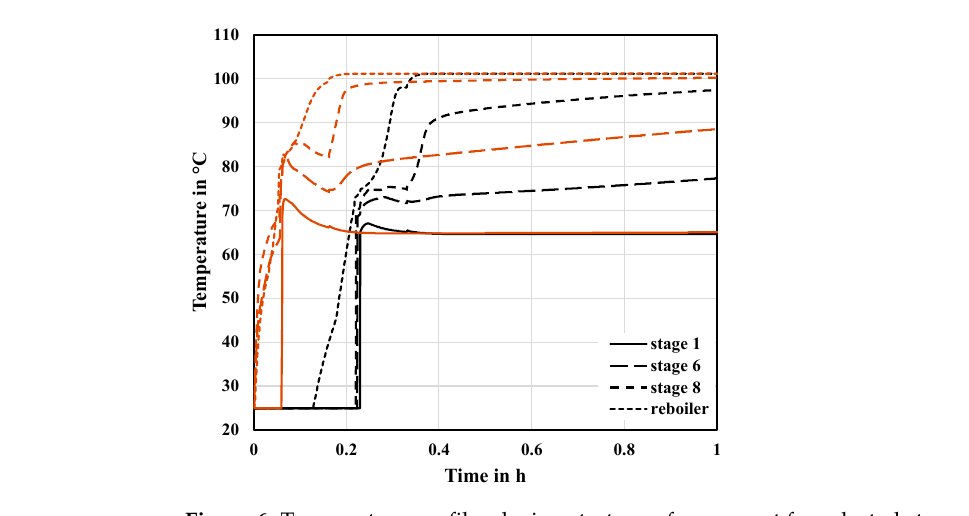
Figure 8. Overall MX-function of the active segment during activation of the adjacent segment. In case C2, the point at which the feed is introduced into the second segment is fur- ther delayed. In this way, an additional reduction in the start-up time is obtained. In com- parison to the base case, the time until the distillate reaches a steady state is reduced by 57.67%. The overall time until a steady state is reached is reduced by 31.42%. As can be seen in Figure 7, the system is able to better compensate for the disturbances caused by the feed. While the gradient at the beginning is lower than in case C1 due to the reduced